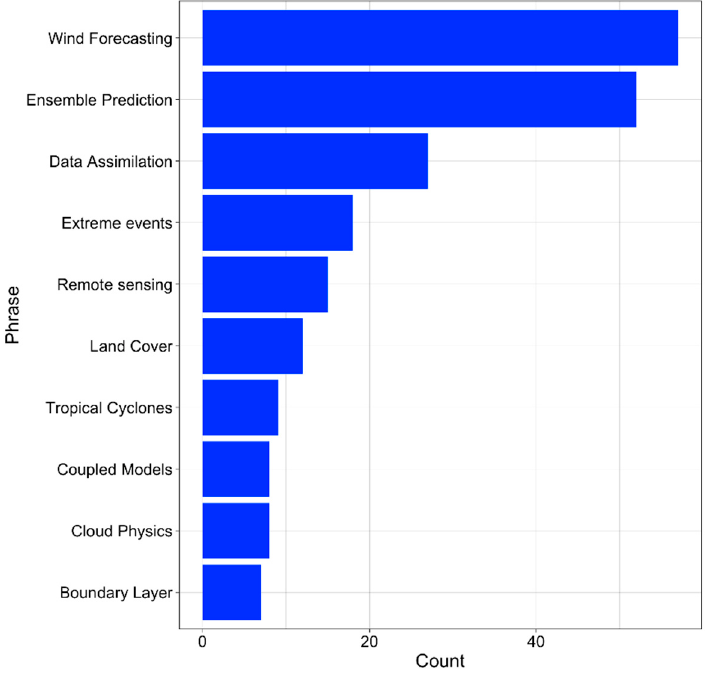
Figure 2. Most common phrases from articles related to numerical weather prediction and machine learning.